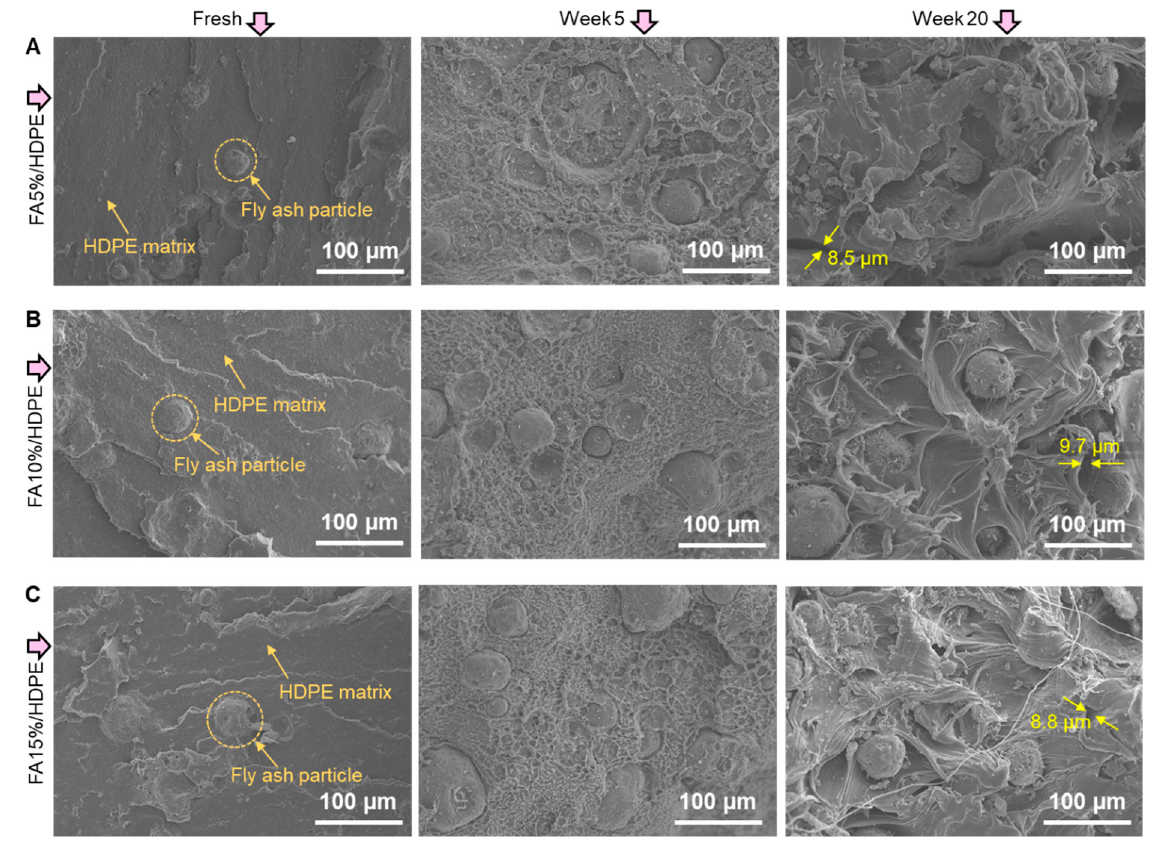
Figure 4. Fracture surface morphology of FA/HDPE samples before and after ageing in a QUV chamber: ( A ) FA5%/HDPE, ( B ) FA10%/HDPE, ( C ) FA15%/HDPE.